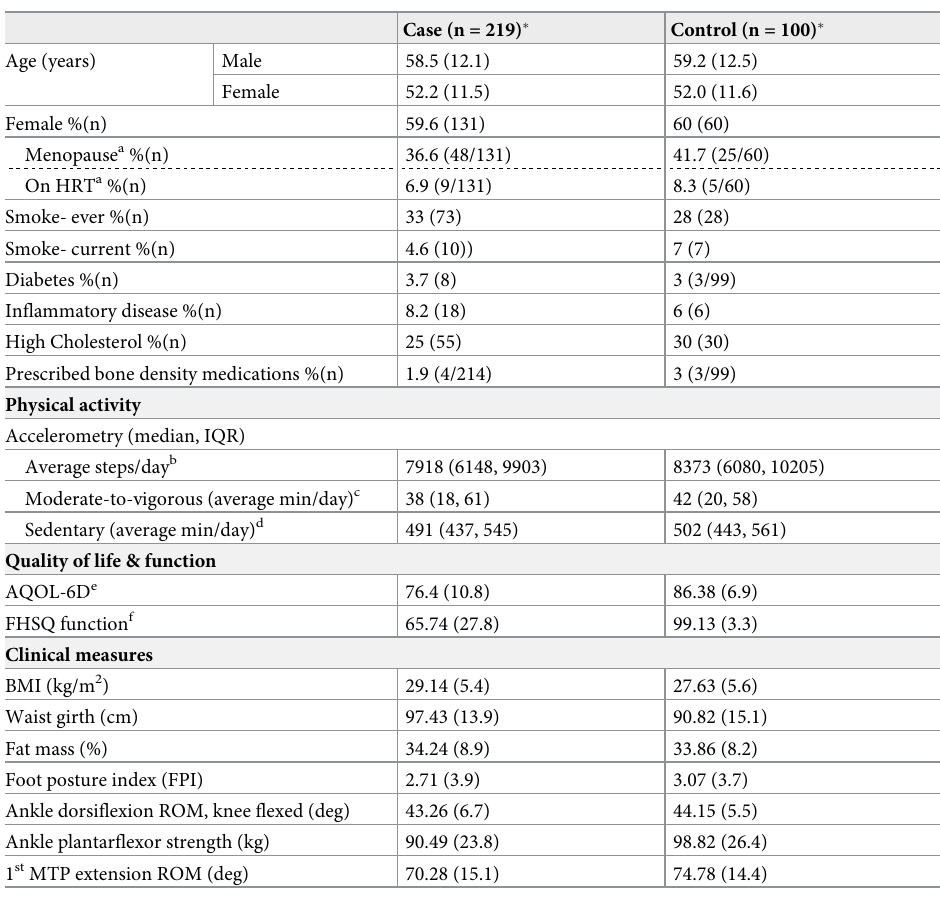
Table 1. Characteristics of case and